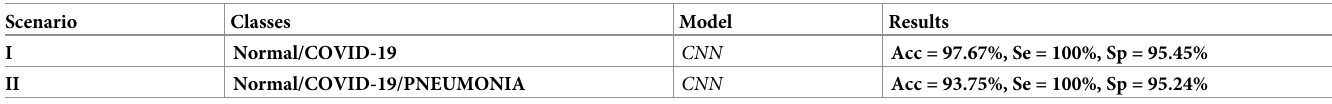
Table 9. Average performance of the build CNN